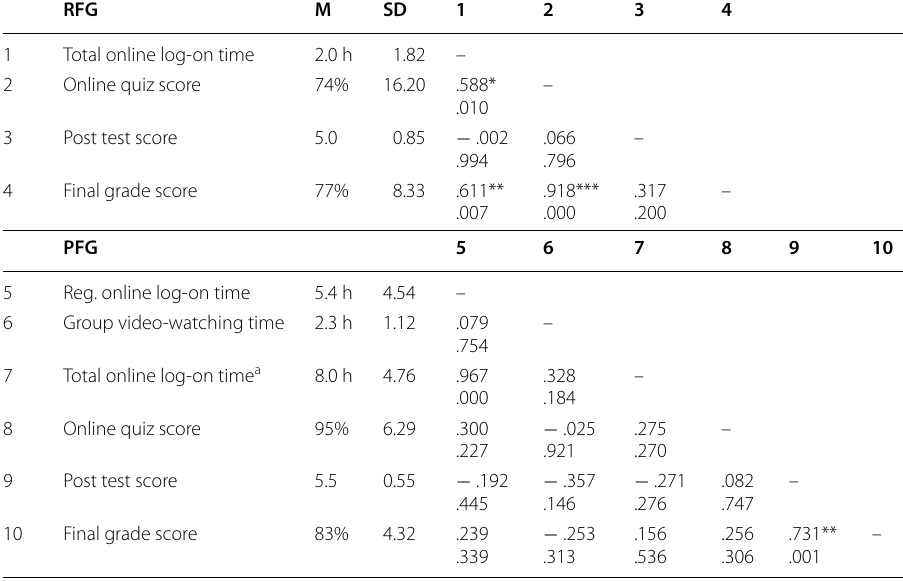
Table 8 Correlation—online learning behavior and objective performance